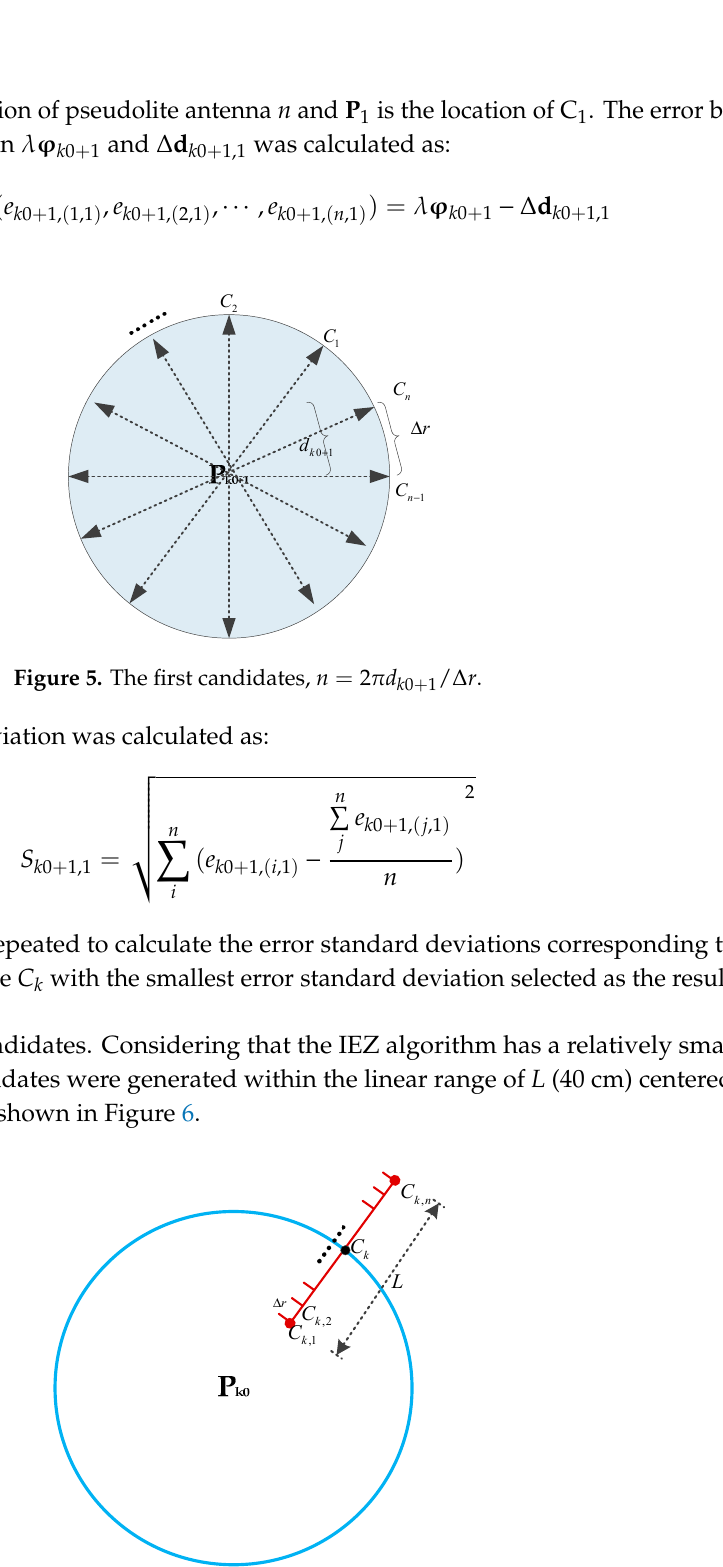
Figure 6. The second candidates, / n L r